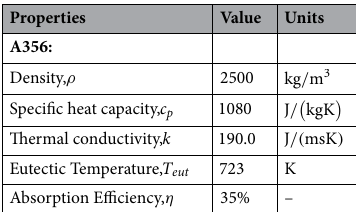
Table 2. Simulation